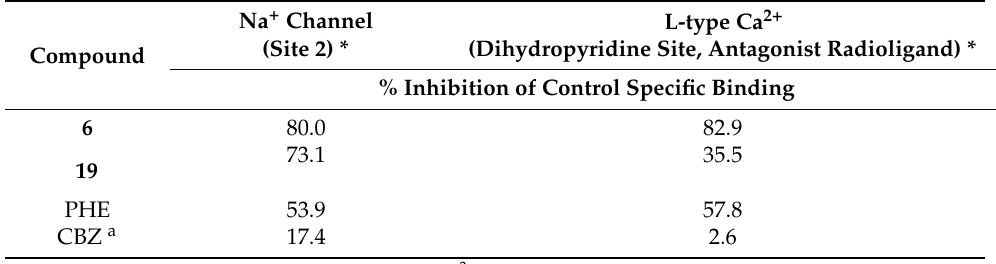
Table 4. In vitro binding assays (concentration 100 µ M).